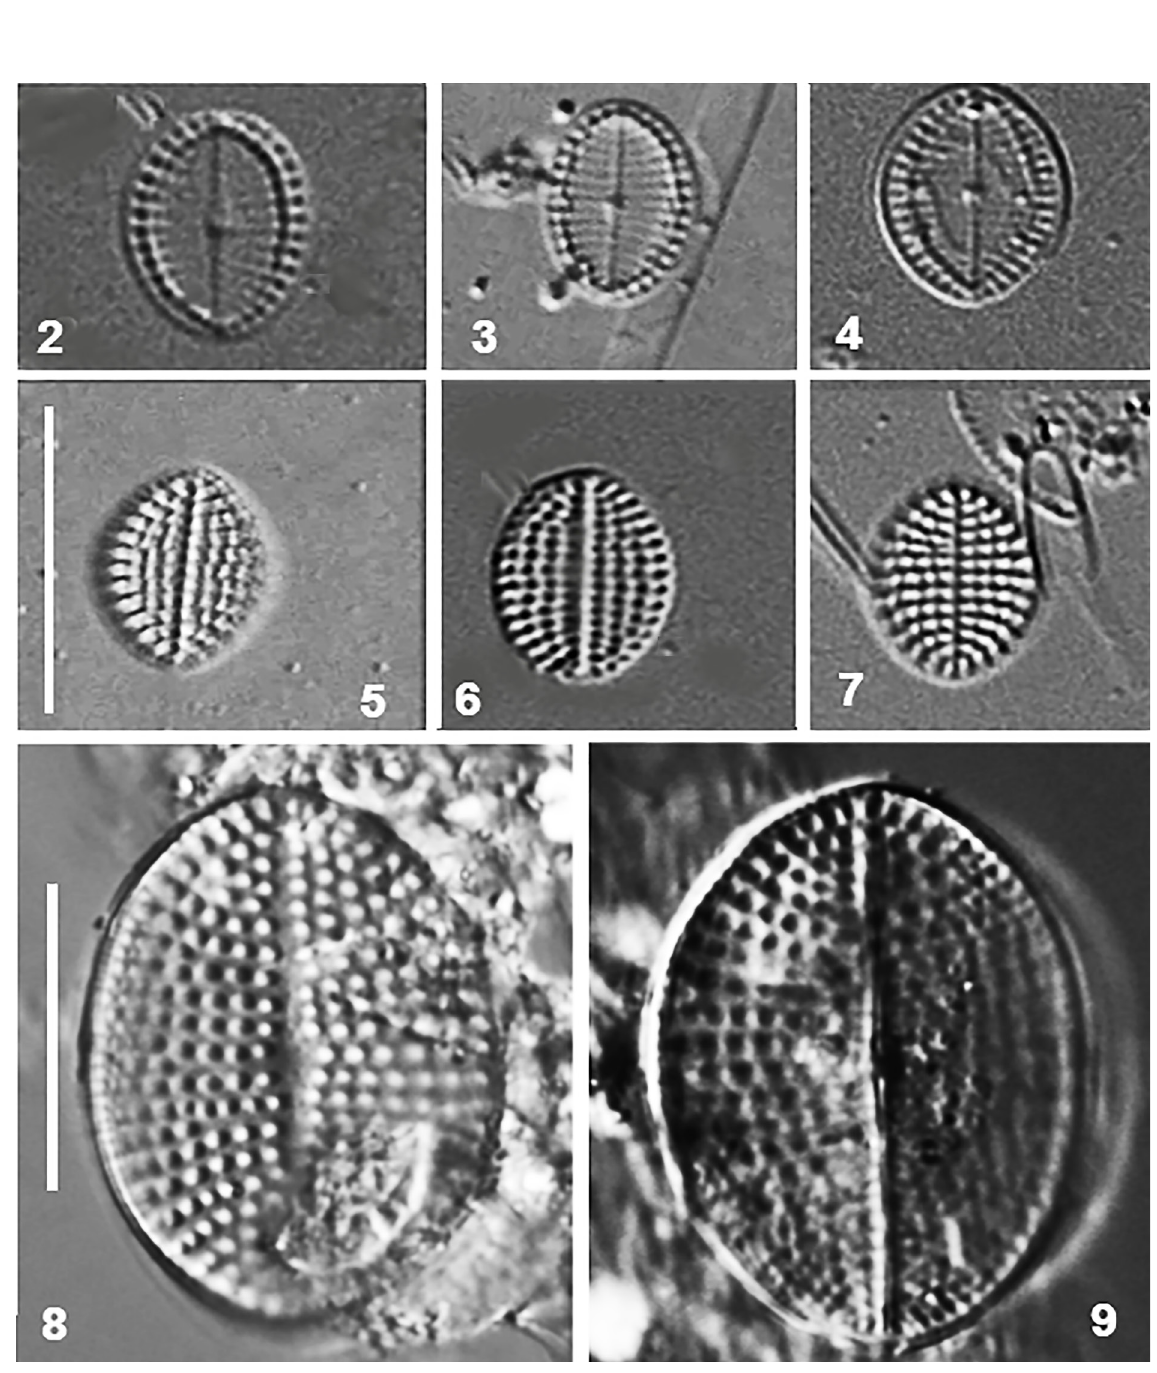
Figs 2–9. LM images. 2–4 . RV of C. magnoareolata Al-Handal, Riaux-Gob., R.Jahn & A.K.Wulff sp. nov., showing variations in size and valve outline (BGBM, slide B 40 0043104). 5–7 . SV of C. mag- noareolata sp. nov. (BGBM, slide B 40 0043104). 8–9 . SV and RV of C. arenicola Ryznik (ANSP, slide no. 62634). Scale bars: 10